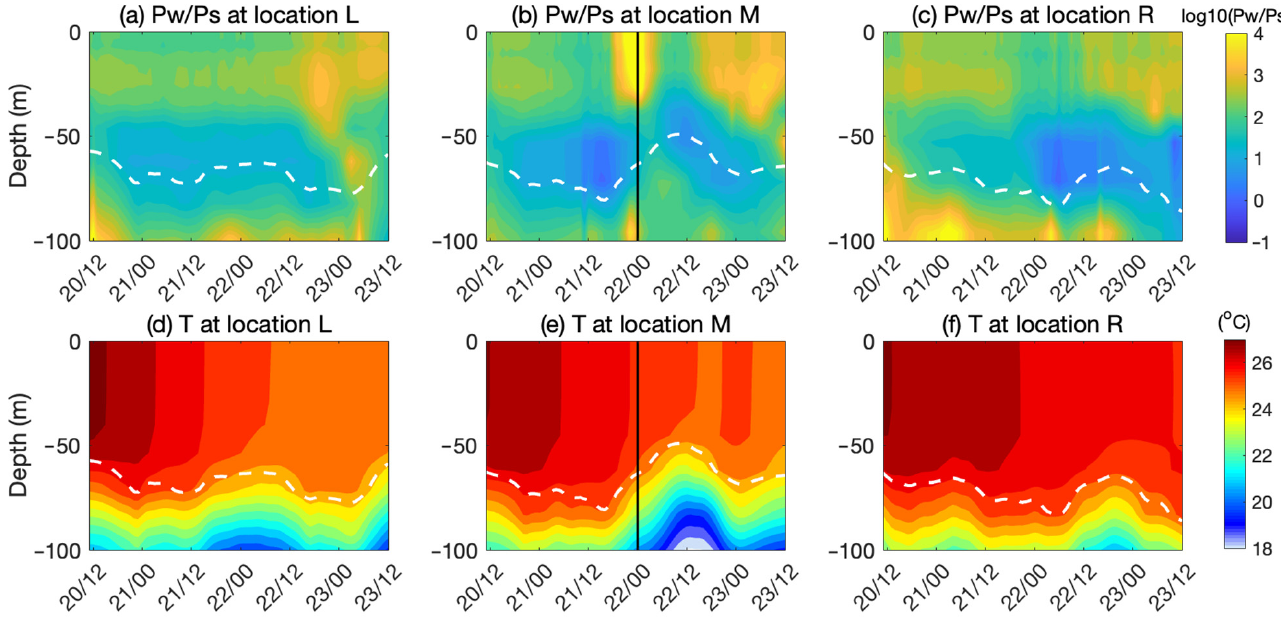
Figure 12. ( a – c ) The ratio of the shear production ( Ps ) and wave orbital motion-induced turbulence production ( Pw ) in different zones of L, M, and R of experiment E2. ( d – f ) The temperature in different zones of L, M, and R of experiment E2. The black vertical lines in panels ( b , e ) display the time when typhoon center passed. The MLDs are marked by white dashed lines.